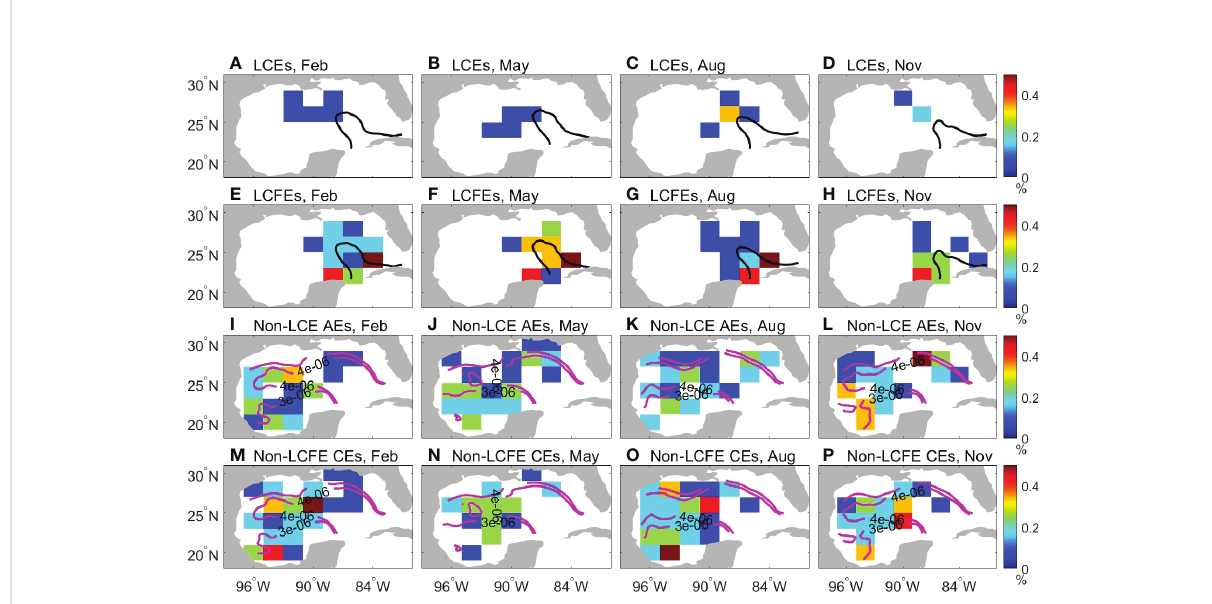
FIGURE 10 (A-D) LCE percentage relative to the total generated eddies in (A) February, (B) May, (C) August, and (D) November. (E-H) LCFE percentage relative to the total generated eddies in (E) February, (F) May, (G) August, and (H) November. (I-L) Non-LCE AE percentage relative to the total generated eddies in (I) February, (J) May, (K) August, and (L) November. (M-P) Non-LCFE CE percentage relative to the total generated eddies in (M) February, (N) May, (O) August, and (P) November. The black lines in (A-H) represent the mean position of the LC in February, May, August, and November, respectively. The magenta lines in (I-P) represent the monthly climatology of current speed gradient in February, May, August, and November,